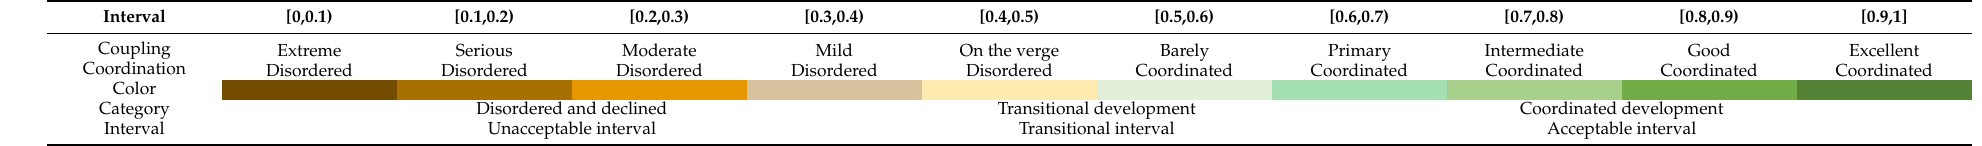
Table 3. Coupling Coordination Classification System and Discriminatory Criteria.